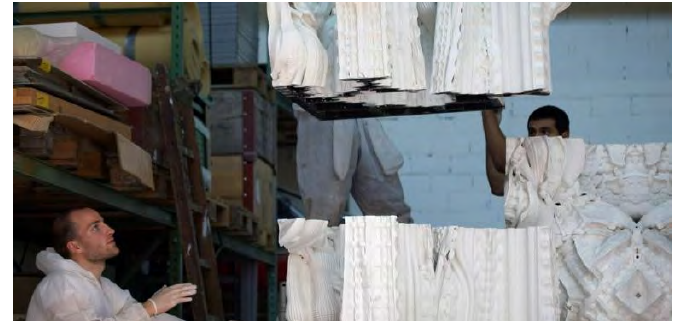
Figure 11. Assemblyin the real life.